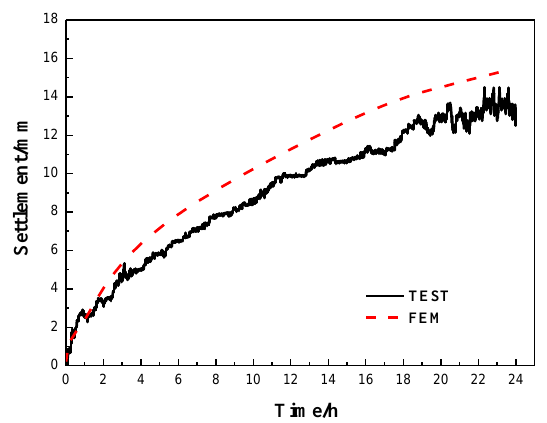
Figure 3. Load and boundary conditions of the finite element model.